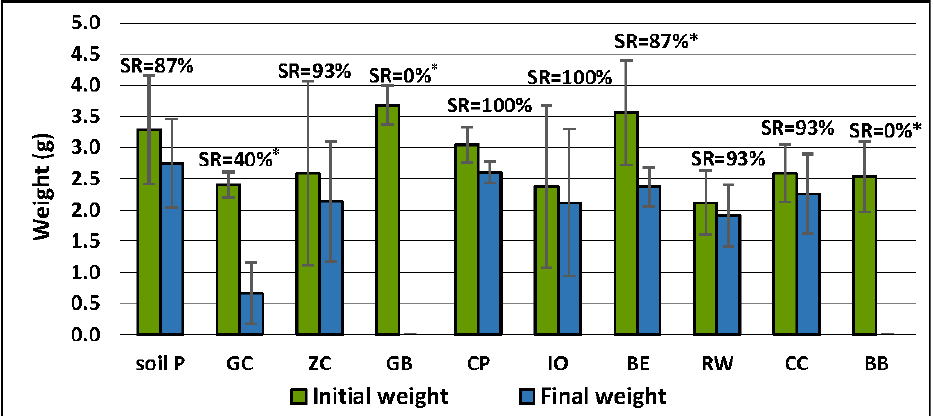
Figure 1. Changes in the weight and survival rate (SR) of earthworms under the influence of soil amend-ments (n=3). The weight change was expressed in normalization to the number of surviving earthworms * significant differences at p < 0.05 in soil between initial and final weight within a given amendment according to the Tukey test; ZC-Zabrze compost, GC-GWDA compost, BB- Bełchatów biosolids, GB-Grabów biosolids, CP-Calcium phosphate, IO-Iron oxide, BE-Bentonite, RW-Rock waste, CC-Limestone .